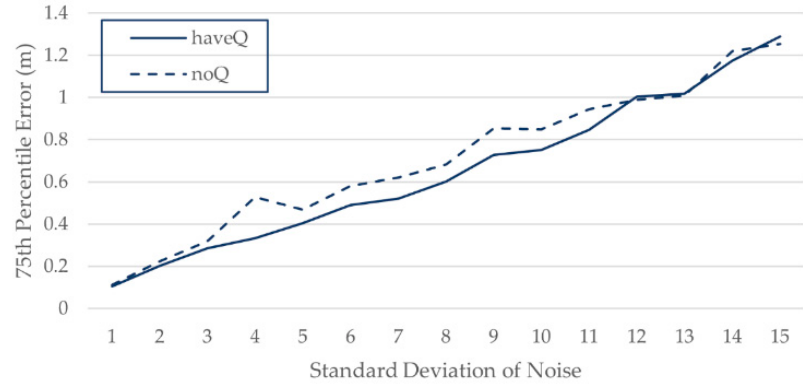
Figure 5. Positioning error of different noise standard deviations on simulated data. Signals from different AP have different paths to TP, and the corresponding η is also different. In addition, the value of η is often unknown in the real world. In order to simulate the unknown state of η in the real world, we assumed that η was unknown and experimented with Q corresponding to different values of η in the range 3–6. It can be seen from Figure 6 that the improvement of positioning accuracy becomes insignificant or even decreases when η deviates greatly from the true value of 4.5, and the base Q has a certain smoothing effect when η is 3.9–5.4, which is around the true value of 4.5.